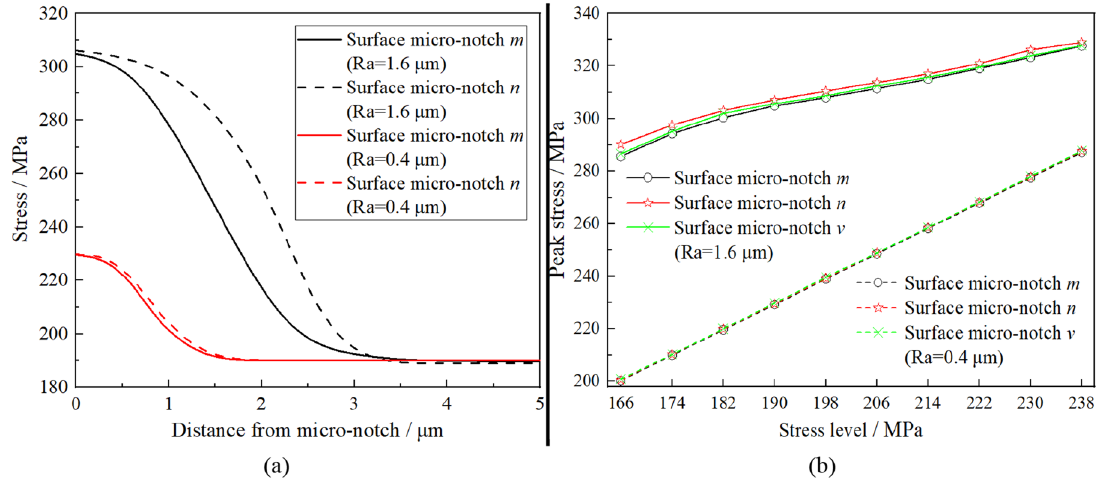
Figure 8. Stress states on the symmetrical line of different micro-notches ( a ) and peak stresses under the different stress leveles ( b ) with different surface roughness.